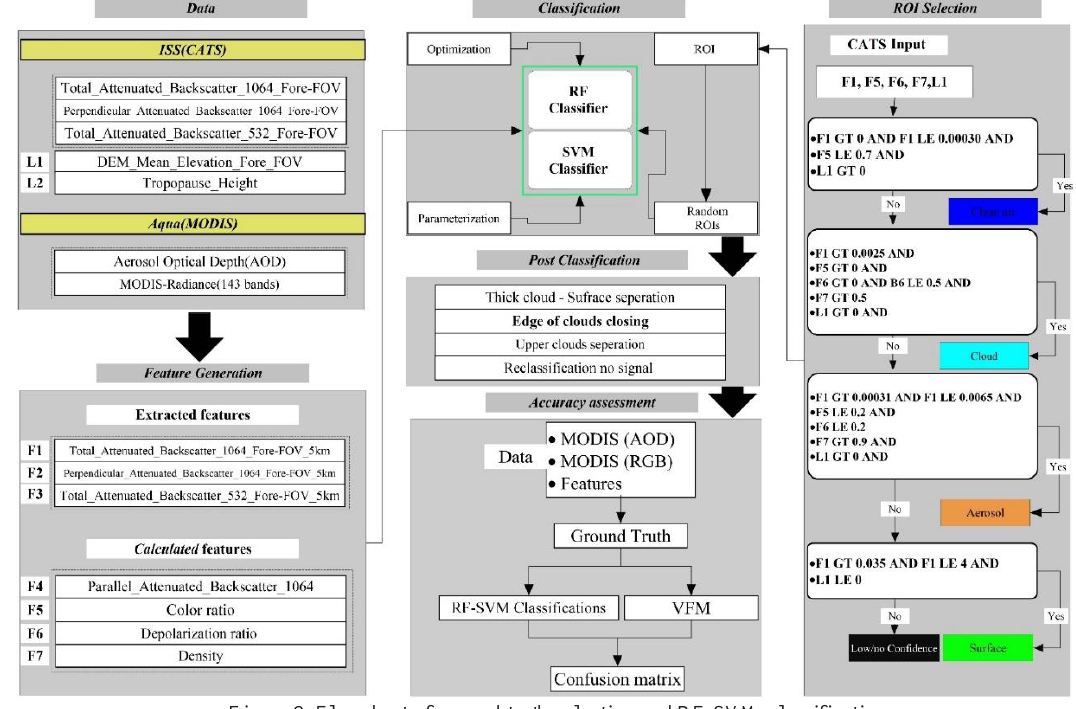
Figure 2. Flowchart of ground truth selection and RF-SVM classifications